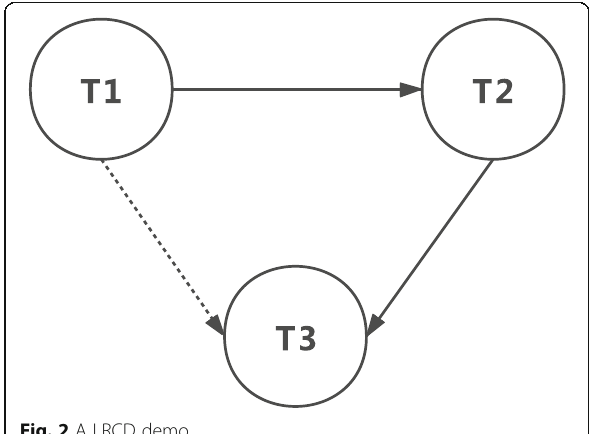
Algorithm implementation of